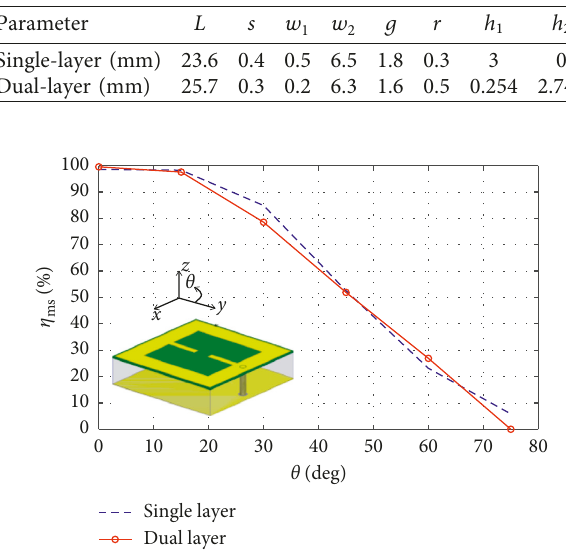
Figure 3: Simulated unit-cell absorption efficiency at 2.45GHz as a function of the incidence angle (TE